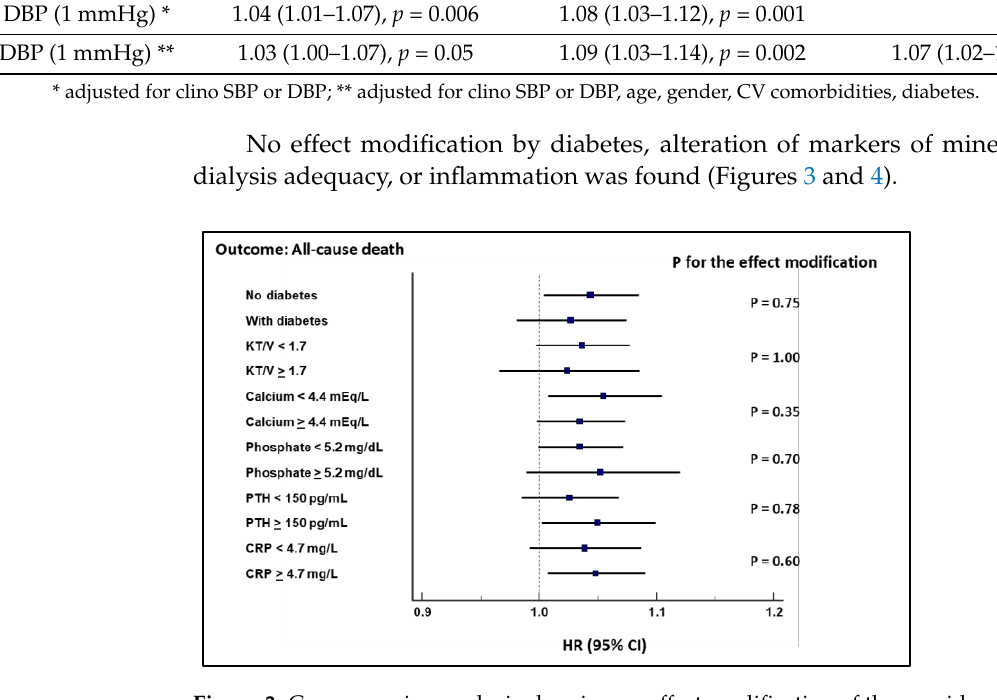
Figure 3. Cox regression analysis showing no effect modification of the considered variables on the association between diastolic changes and all-cause death.